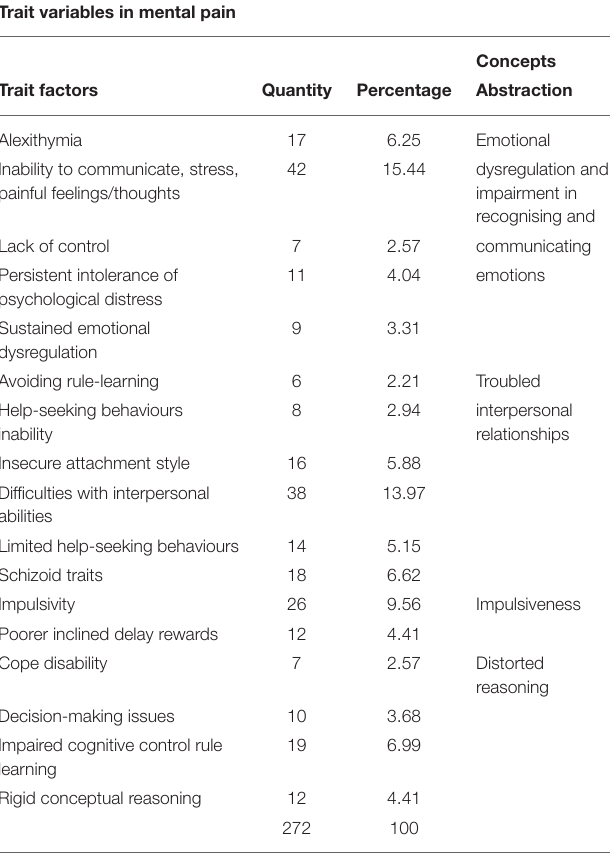
TABLE 3 | Subjective styles of experience (relatively stable personality) obtained in concepts analysis. Trait variables in mental